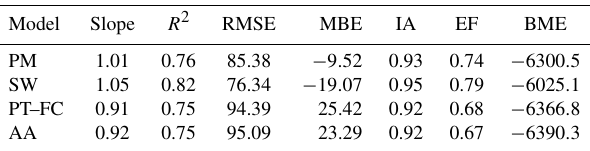
Table 3. Slope and coefficient of determination ( R 2 ) of regression between measured and modeled half-hourly evapotranspiration val- ues, and statistics of root mean square error (RMSE), mean bias error (MBE), index of agreement (IA), model efficiency (EF) and Logarithm of BME for the four ET models. Model